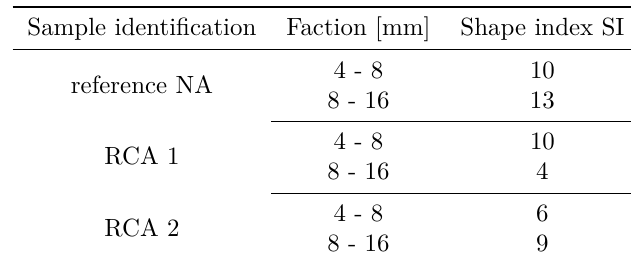
Table 5. Determination of the shape index.